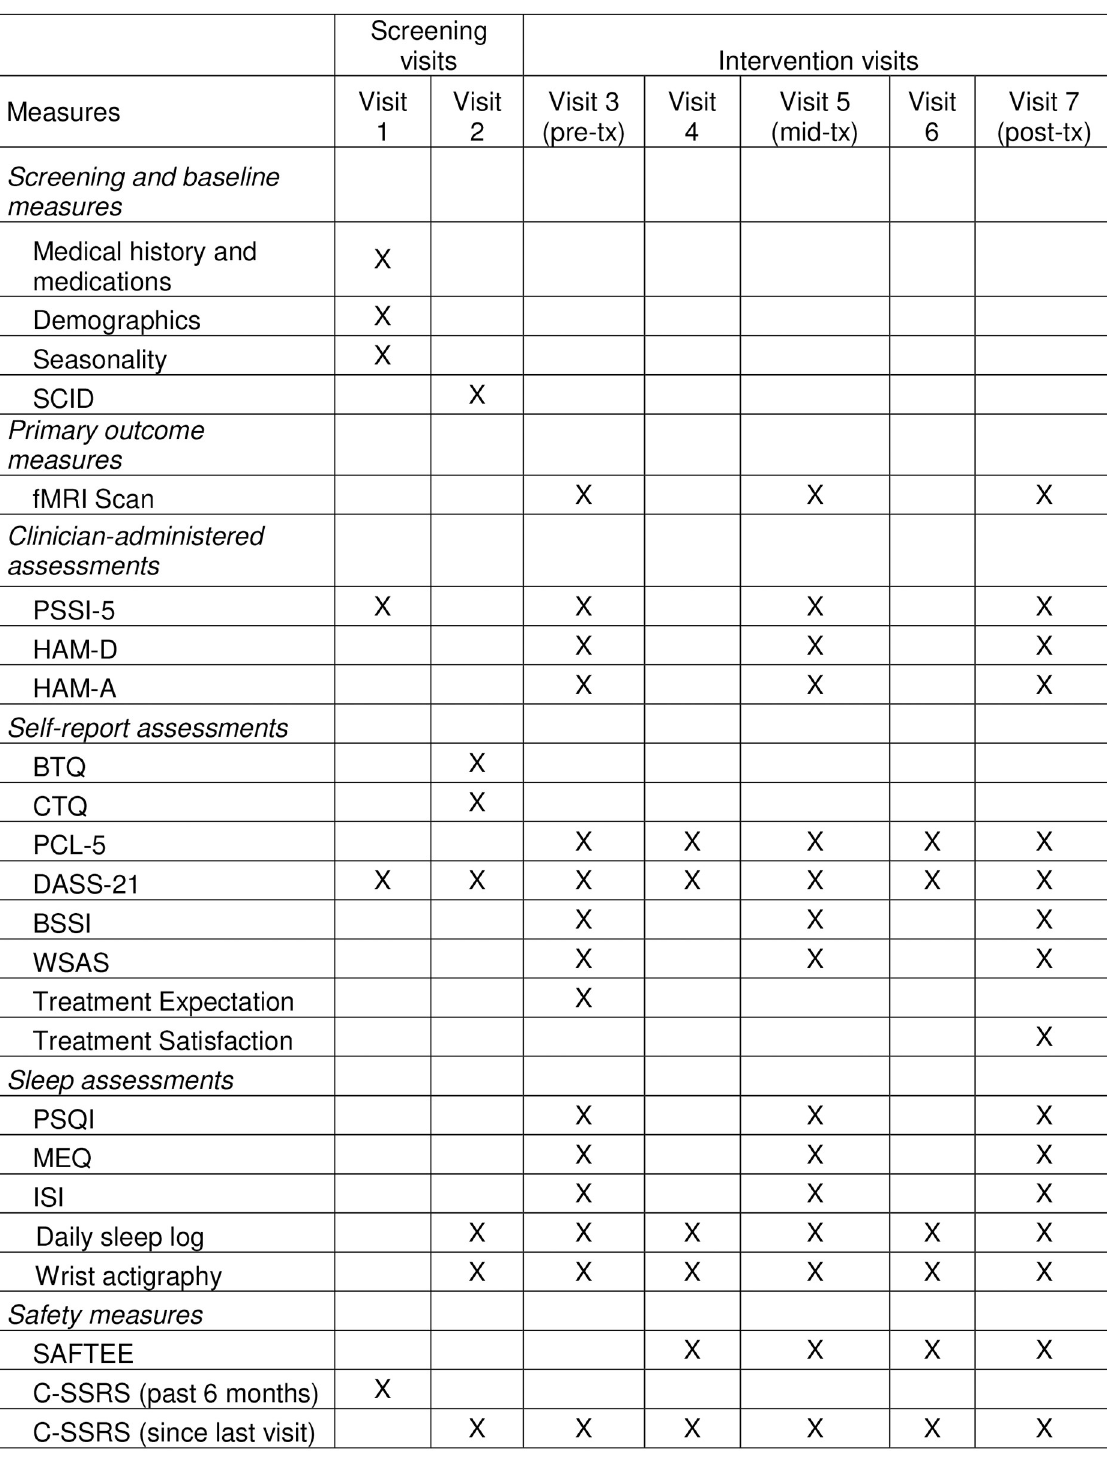
Fig 1. Schedule of measure administration. SCID = Structured Clinical Interview for DSM-5; PSSI-5 = PTSD Symptom Scale–Interview for DSM-5; HAM-D = Hamilton Depression Rating Scale; HAM-A = Hamilton Anxiety Rating Scale; BTQ = Brief Trauma Questionnaire; CTQ = Childhood Trauma Questionnaire; PCL-5 = PTSD Checklist for DSM-5; DASS-21 = Depression, Anxiety and Stress Scale– 21 item; BSSI = Beck Scale for Suicidal Ideation; WSAS = Work and Social Adjustment Scale; PSQI = Pittsburgh Sleep Quality Index; MEQ = Morningness Eveningness Questionnaire; ISI = Insomnia Severity Index; SAFTEE = Systematic Assessment for Treatment Emergent Events; C-SSRS = Columbia Suicide Severity Rating Scale. Wrist actigraphy is collected continuously and sleep logs are collected daily between visits 2 and 7.